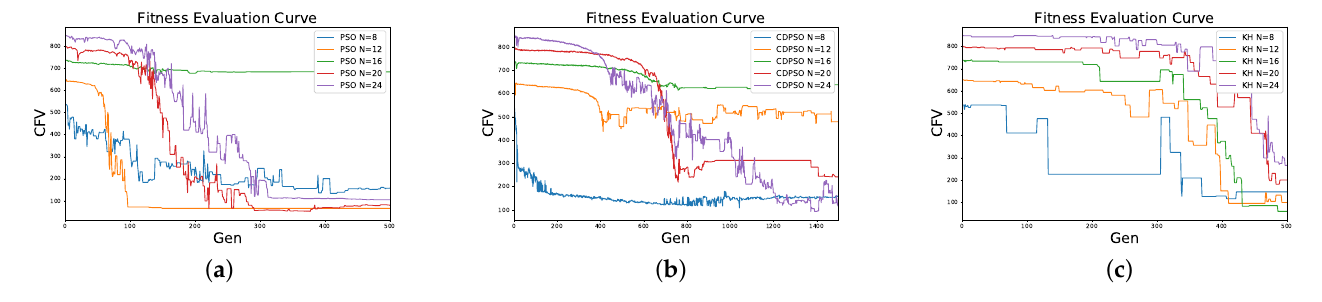
Figure 3. The convergence curves of PSO ( a ), CDPSO ( b ), and KH ( c ).